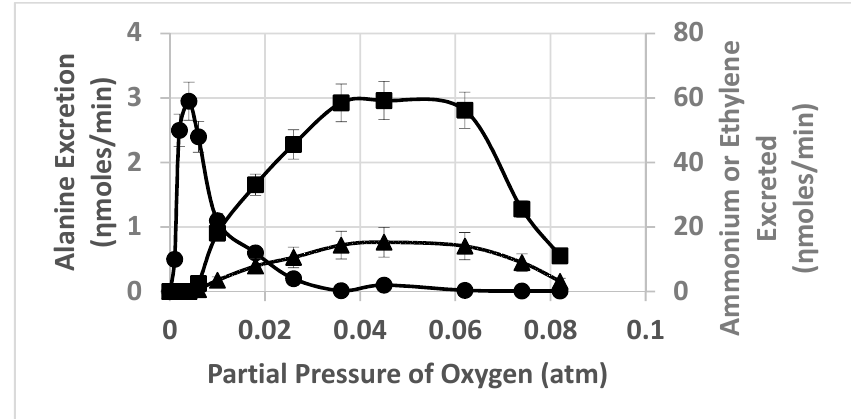
Figure 1. Effect of oxygen partial pressure on alanine excretion, ammonium release and ethylene formation from acetylene by ex planta B. diazoefficiens bacteroids. Assays were performed as described in Section 4. Bacteroid amount was 4.8 mg bacteroid dry weight. Values are the mean plus range of duplicate values; circles—alanine, triangles—ammonium, squares—ethylene.